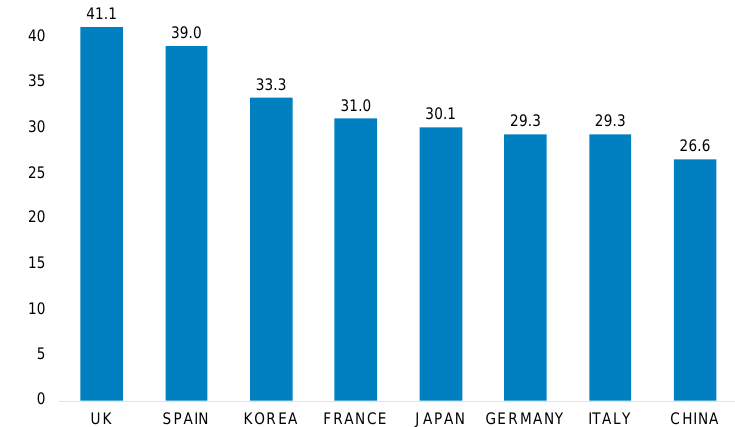
Figure 1. Prevalence of lung metastases among patients with UICC stage IV metastatic colorectal cancers in eight countries of Europe and